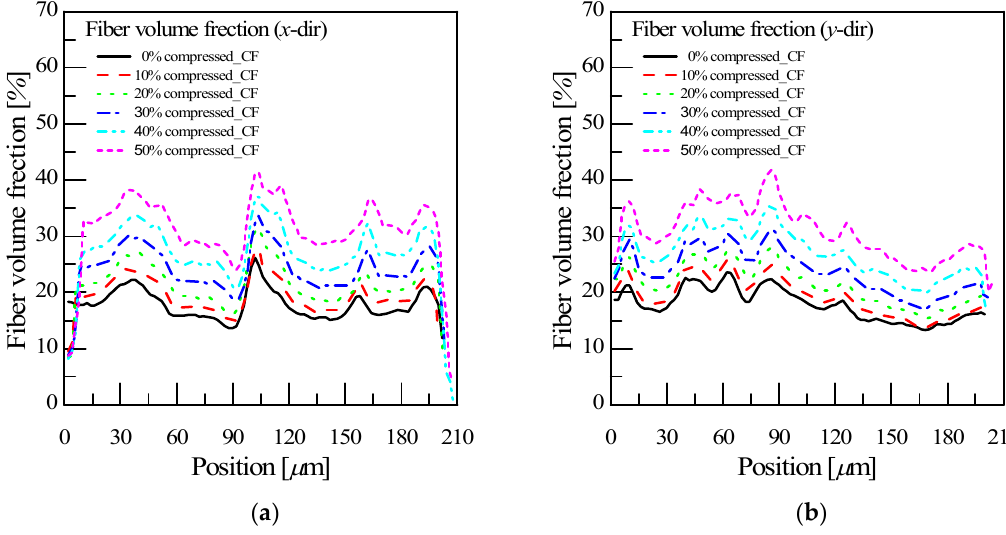
Figure 2. Generated fiber volume fraction for different compression ratios: ( a ) Fiber volume fraction ( x -dir); ( b ) fiber volume fraction ( y -dir).